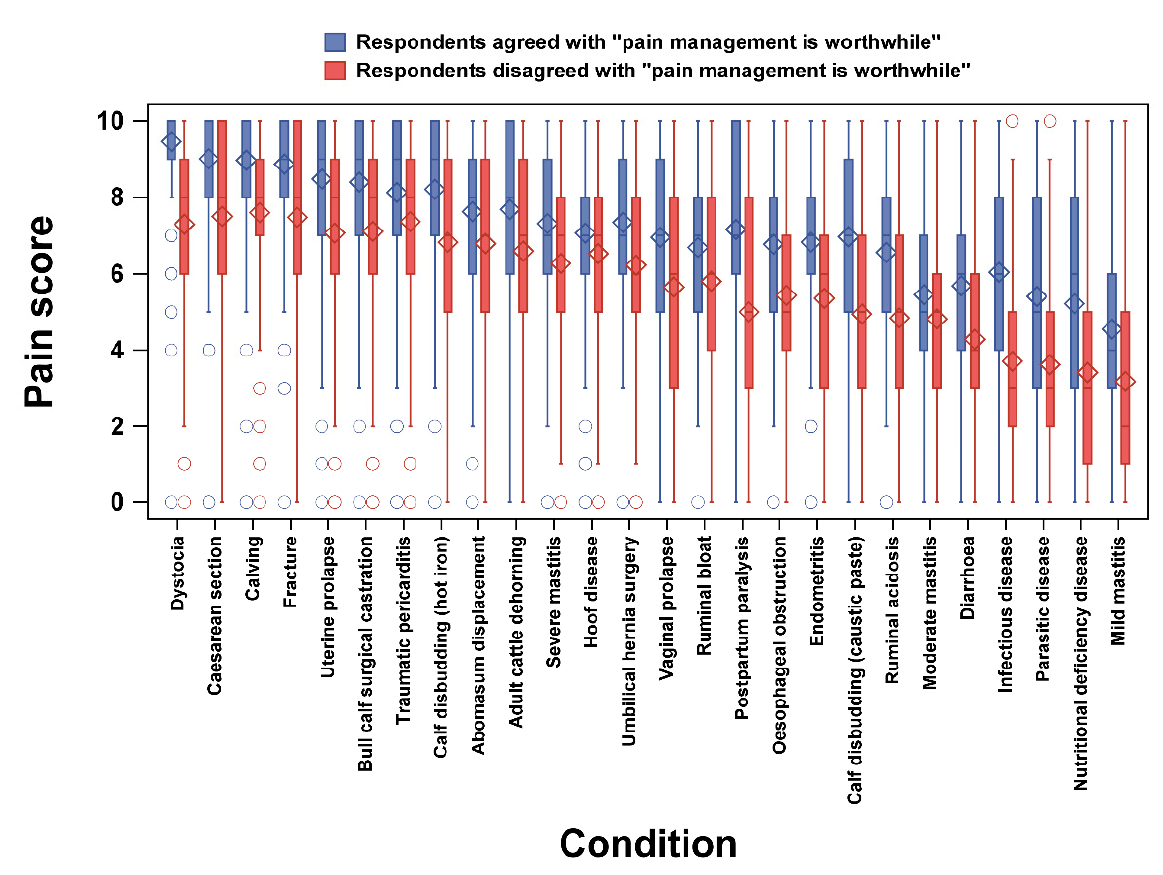
Figure 2. Pain scores given by respondents who agreed and disagreed with the statement “pain management is worthwhile” among 26 painful conditions. Diamonds and circles indicate means and outliers (out of 1.5 intra-quartile range), respectively. Table 3. Rotated component matrix for the first two principal components after eliminating the correlation coefficients less than 0.48 1